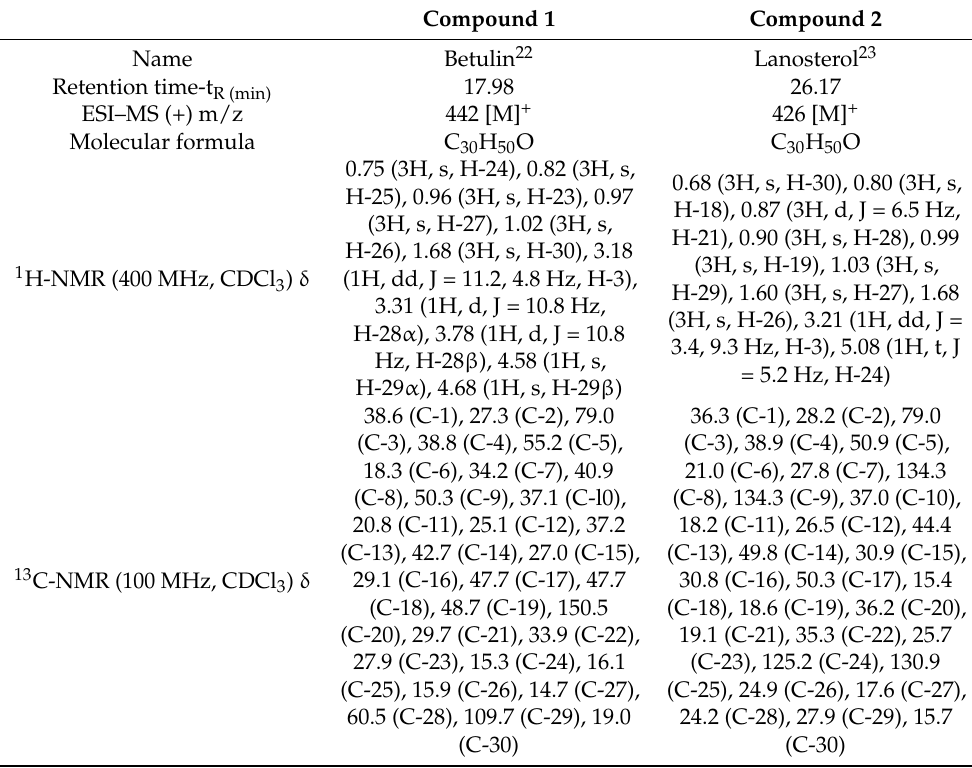
Table 5. Main features of compounds 1 and